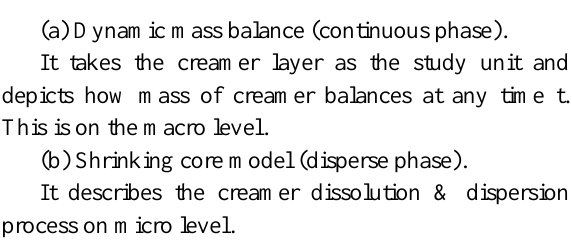
Fig. 1. The approach, it gives the outline of this